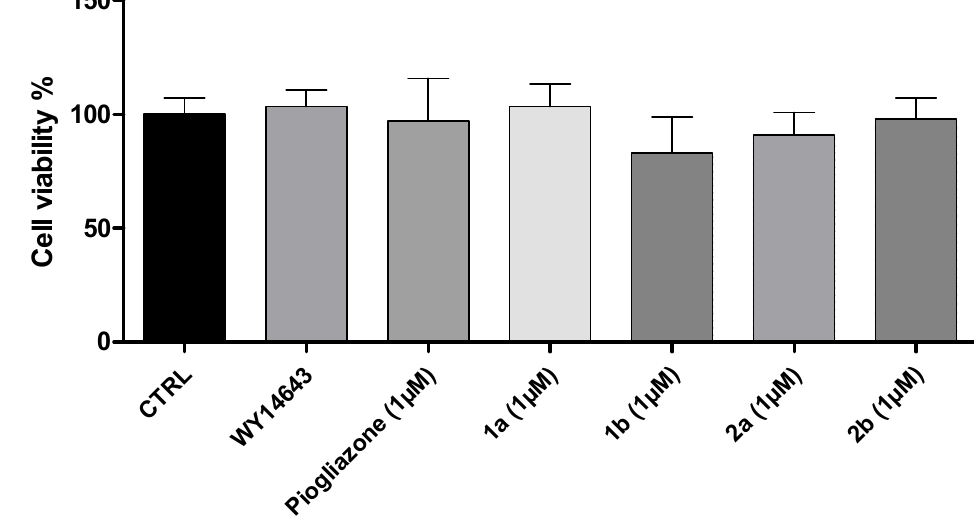
Figure 2. An MTT assay of human fibroblast (HFF-1) cells treated with WY-14643 (1 µ M), pioglitazone (1 µ M), 1a (1 µ M), 1b (1 µ M), 2a (1 µ M), and 2b (1 µ M), for 24 h, in basal conditions. Data were reported as means ± SEM.